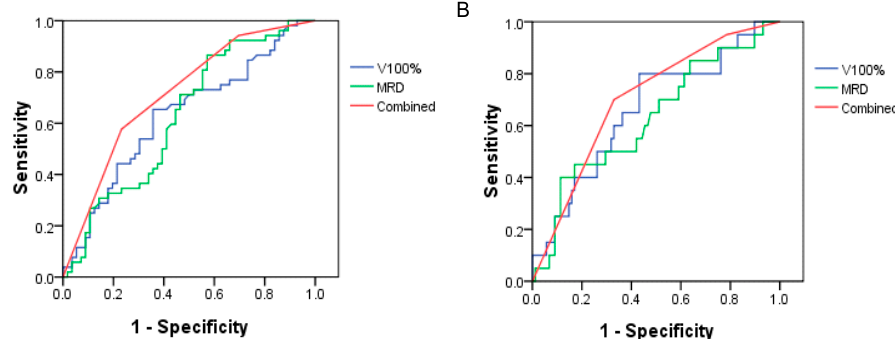
Figure 2. The ROC curve for combination of small bowel volume effect and rectal dose effect on Grade 2 or greater ( A ) and Grade 3 ( B ) diarrhea.